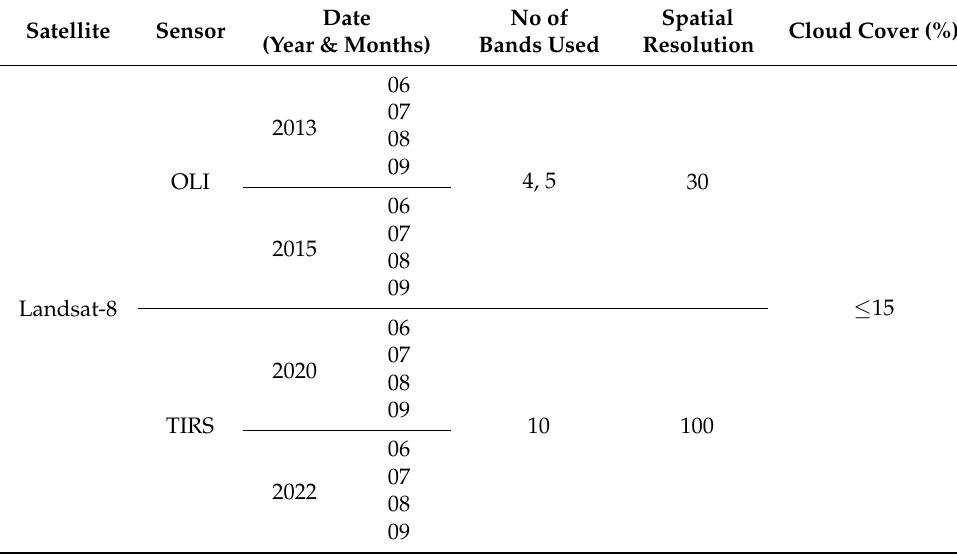
Table 1. Characteristics of the images used in the present study.